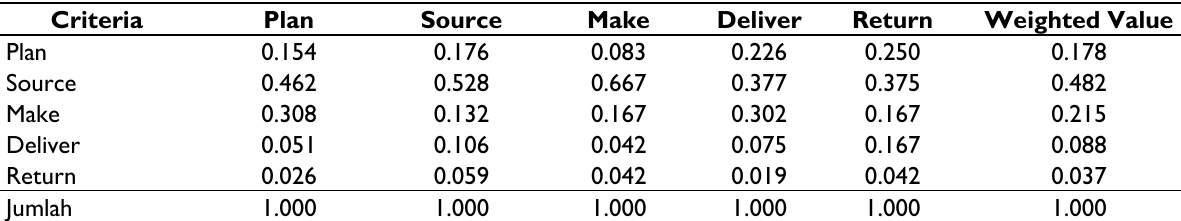
Tabel 8: Cell Value Calculation Matrix at Level 1 Criteria